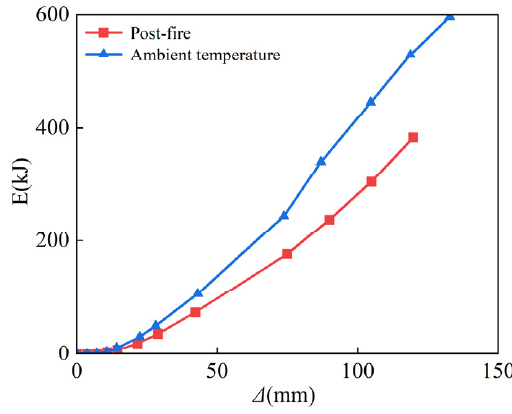
Figure 14. Energy dissipation.